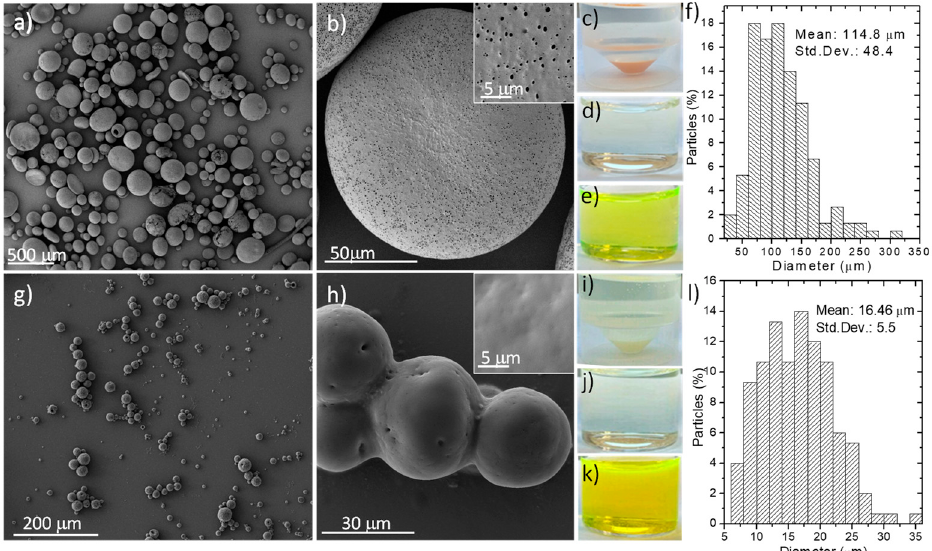
Figure 1. SEM photographs showing the morphology of empty microparticles based on: ( a , b ) Eudragit RS 100; ( g , h ) Eudraguard biotic; ( c ) Optical imaging of an Eudragit-based microparticle suspension in water; ( d ) Optical imaging of the supernatant collected from a Eudragit-based microparticle suspension after 2 h at 37 °C under simulated gastric conditions; ( e ) Optical imaging of the supernatant collected from a Eudragit-based microparticle suspension after 6 h at 37 °C under simulated intestinal conditions; ( f ) Size distribution of Eudragit RS 100 microparticles obtained (N = 150); ( i ) Optical imaging of a Eudraguard-based microparticle suspension in water; ( j ) Optical imaging of the supernatant collected from a Eudraguard-based microparticle suspension after 2 h at 37 °C under simulated gastric conditions; ( k ) Optical imaging of the supernatant collected from a Eudraguard-based microparticle suspension after 6 h at 37 °C under simulated intestinal conditions; ( l ) Size distribution of Eudraguard biotic microparticles obtained (N = 150). Std. Dev. = Standard Deviation.